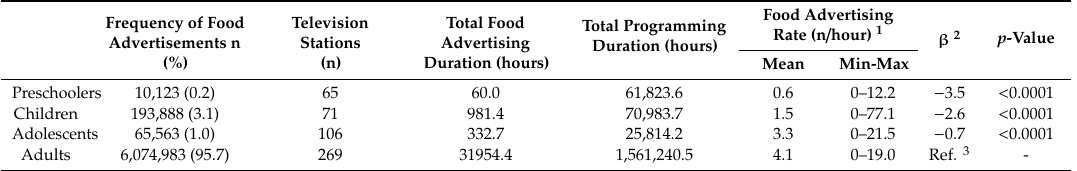
Table 1. Annual frequency, average rate, and duration of food advertising by target age groups, across all Canadian television stations, in